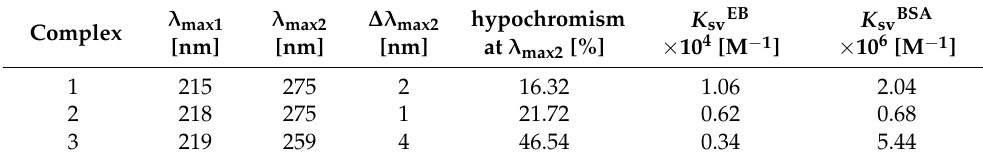
Table 8. Spectral binding parameters of complexes 1 – 3 .